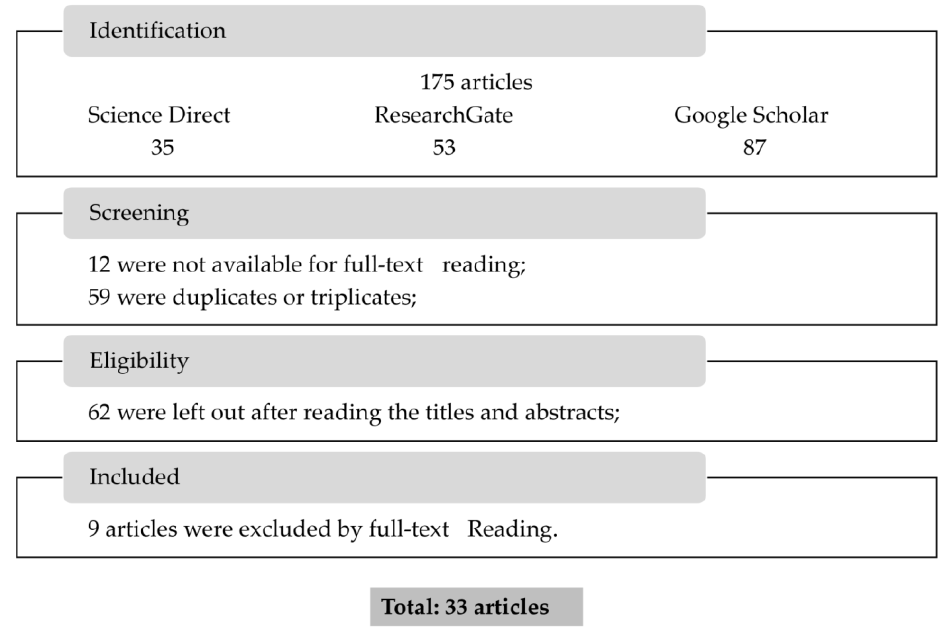
Figure 1. Diagram created using PRISMA that shows the systematic research ’ s findings.